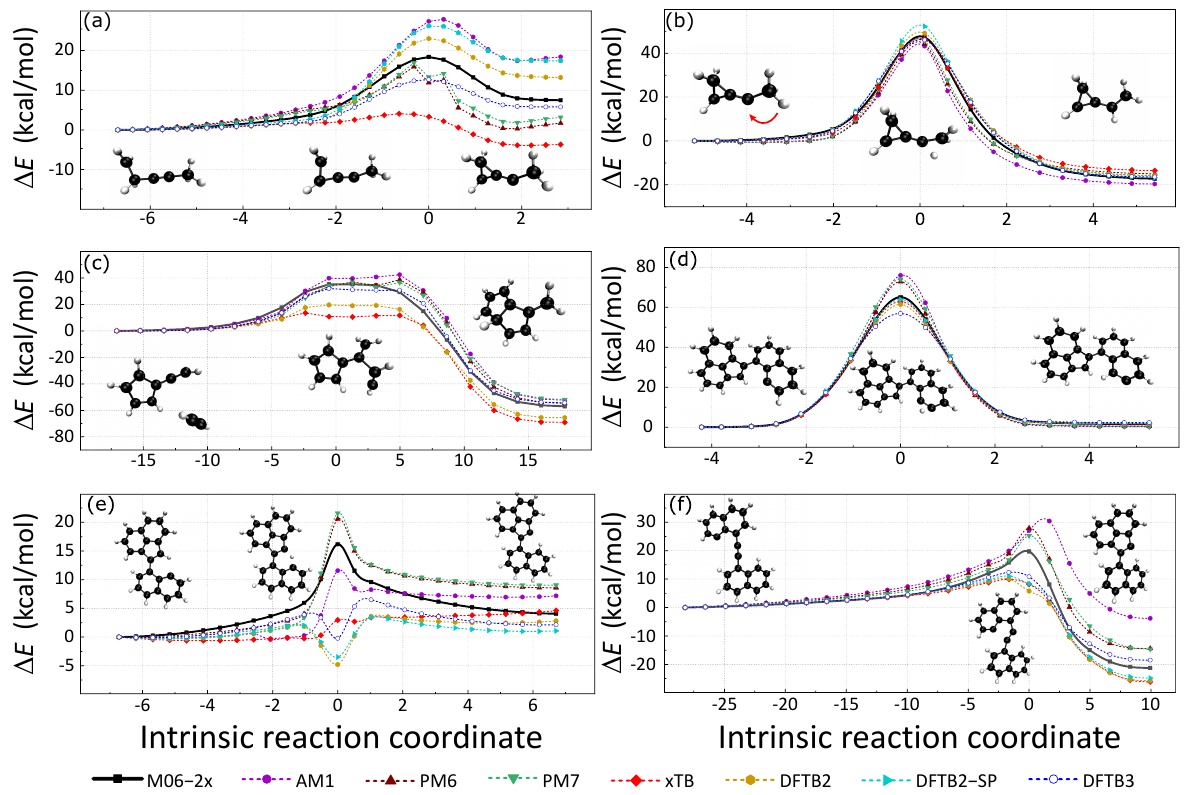
Figure 4. Three C–C formations and three H-migration reactions selected from previous works are shown in this figure. First, we performed the above 6 IRC calculations at the M06-2x/def2TZVPP level, the corresponding data are the black solid lines in the figure. The potential energy corresponding to each data point on the reaction path was then recalculated using various SE methods; each method is represented by a dashed line in a different